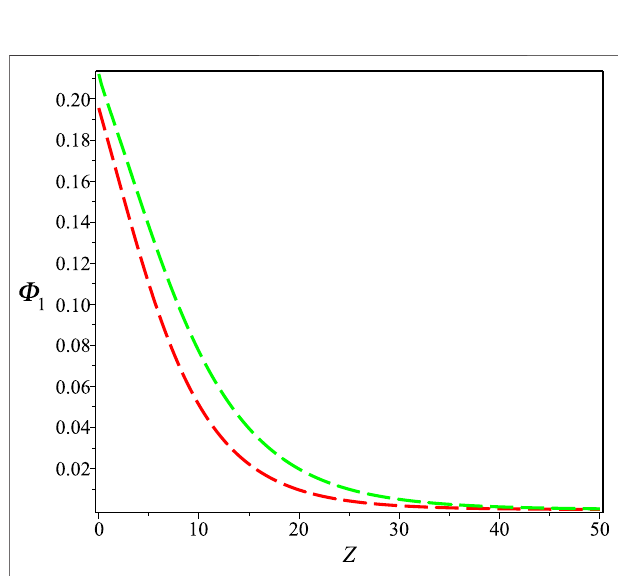
FIGURE6| EffectofrelativisticstreamingfactoronelectrostaticNIASWEsfor (A) β (cid:2) 0.9and (B) β (cid:2) 1with α e (cid:2) 0.5, N p 0 / N e 0 (cid:2) 0.5, d (cid:2) 1, r (cid:2) e , ρ 0 (cid:2) 0.96, T ep (cid:2) 1and T (cid:2) 100.